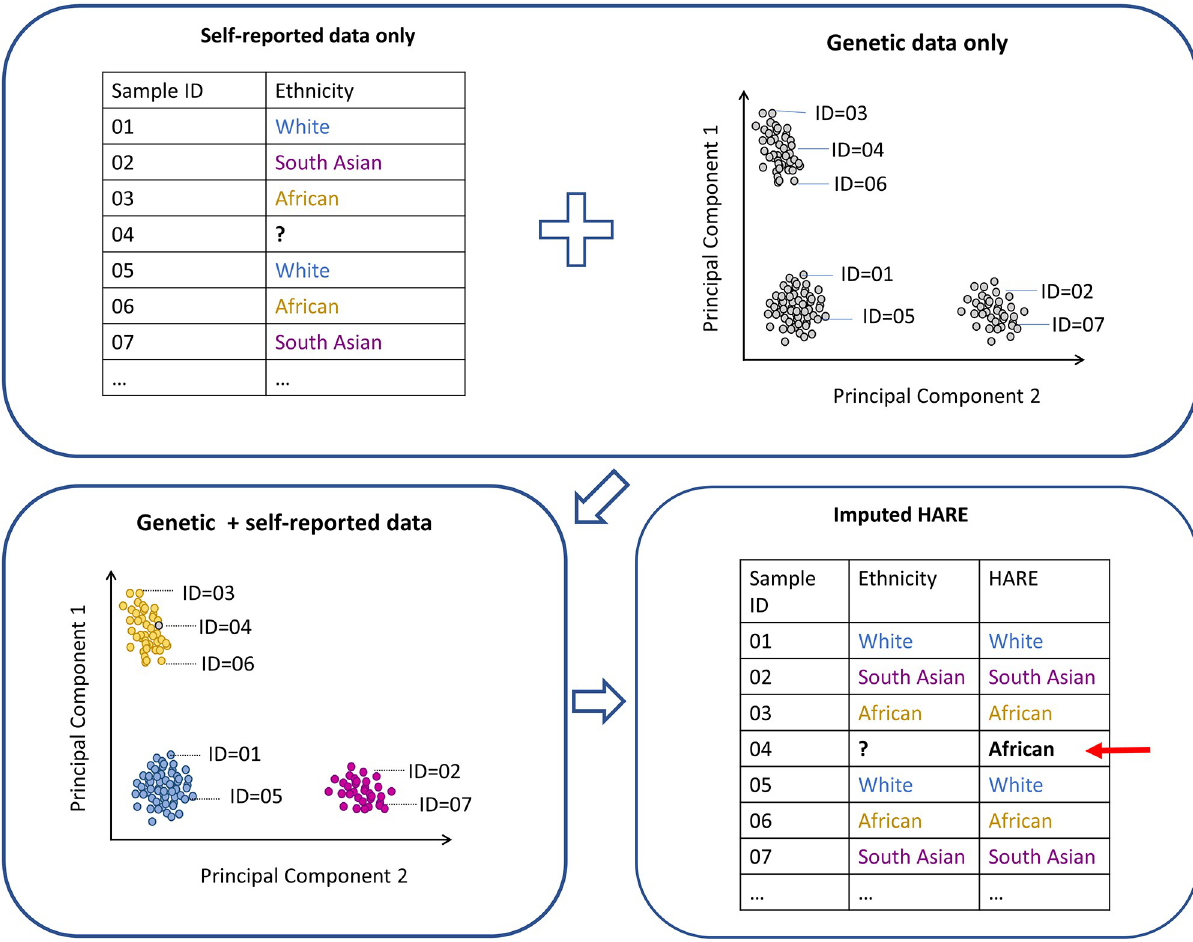
Fig 2. Validation and imputation of self-reported ethnicity using genetic